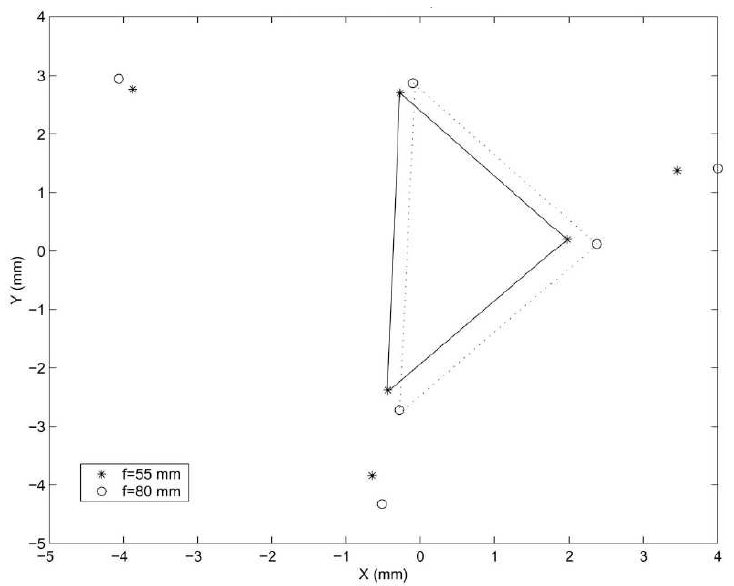
Figure 9. Distortion from calibration variations (reprinted from